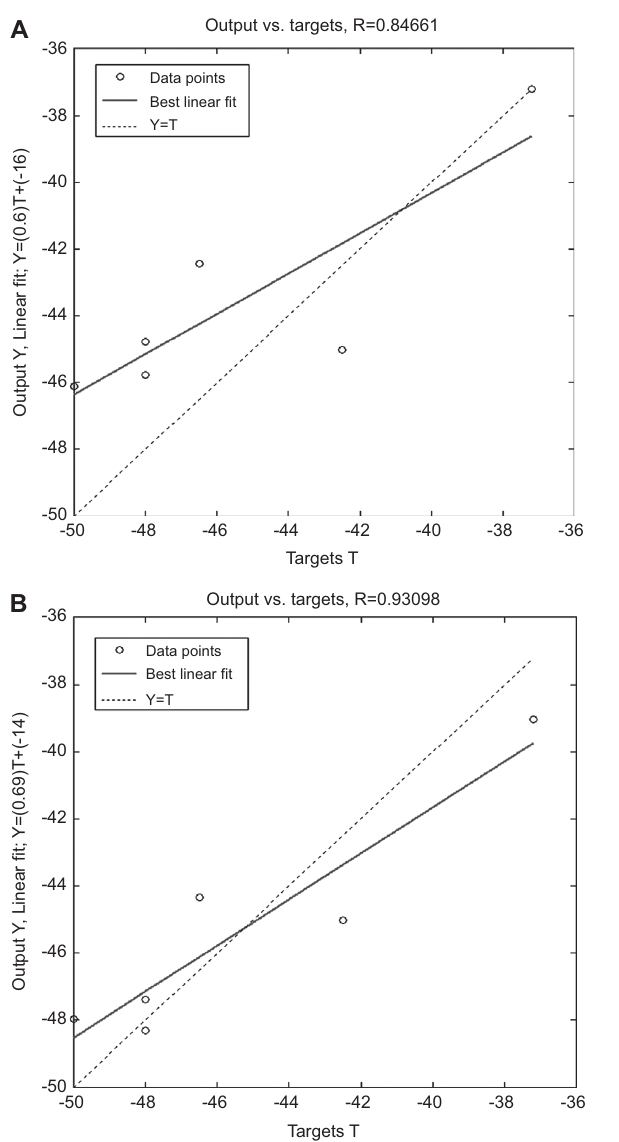
Figure 8 A parity plot among actual experiments and predicted values for the zeta potential response for the TiO obtained using the (A) RSM and (B) ANNs (the vertical and horizontal axes are predicted output and corresponding targets, respectively).